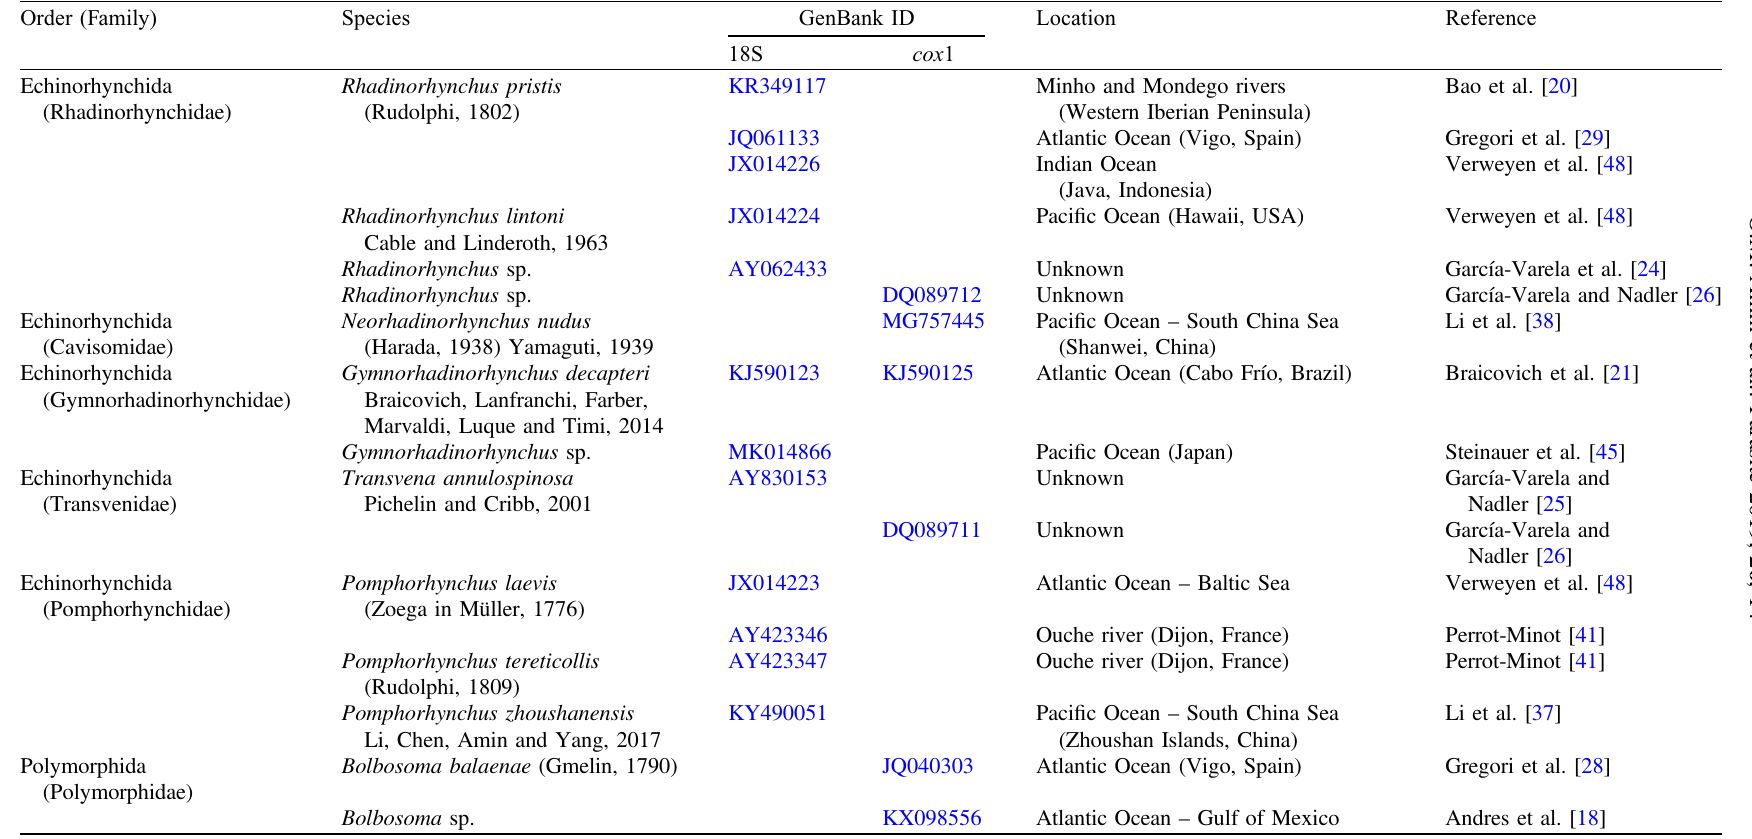
Table 6. Data for the sequences belonging to Paleacanthocephala retrieved from GenBank and included in the phylogenetic analyses. Order